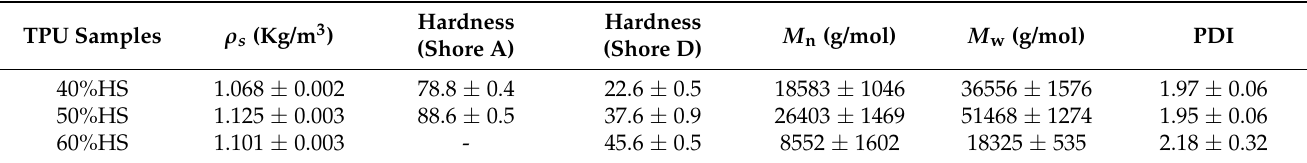
Table 2. Properties of TPU samples: the density of the solid TPU ( ρ s), Shore hardness, number-averaged molecular weights ( M n ), weigh-averaged molecular weights ( M w ) and polydispersity index (PDI). TPU